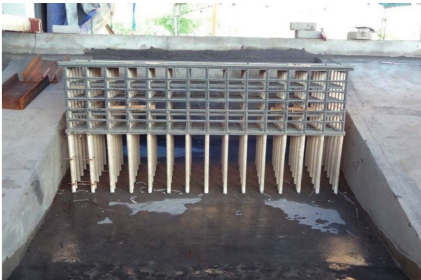
Figure 4: The layout of wharf in the test.